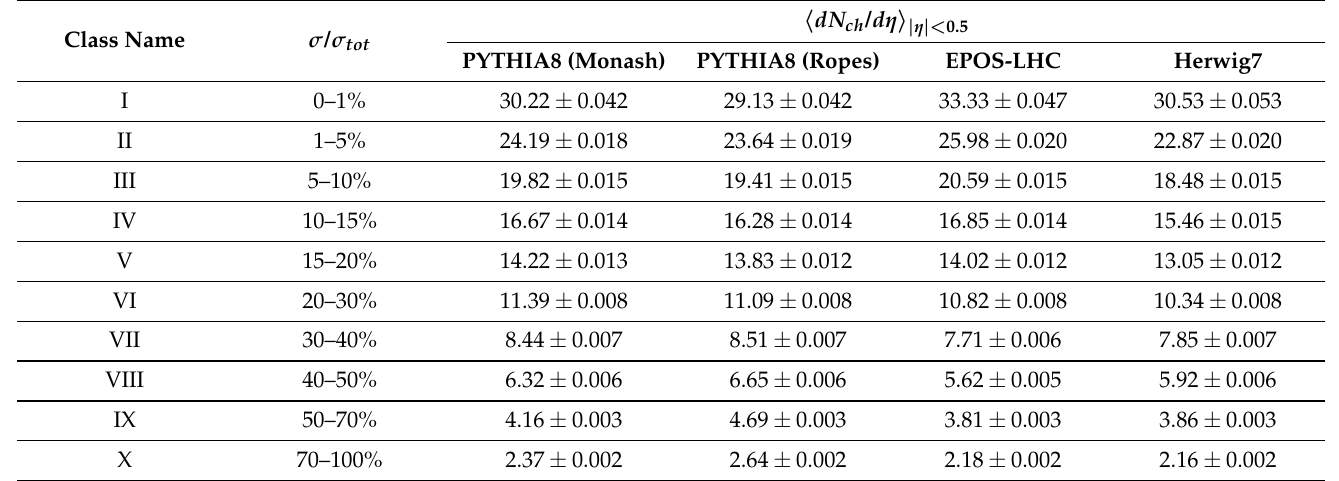
Table 1. Event multiplicity classes, their corresponding fraction of the cross-section ( σ / σ tot ) and < 0.5) for PYTHIA8 (Monash), PYTHIA8 (Ropes), dN ch / d η η their corresponding at midrapidity ( (cid:104) (cid:105) | | EPOS-LHC, and Herwig7 at √ s = 20 TeV.